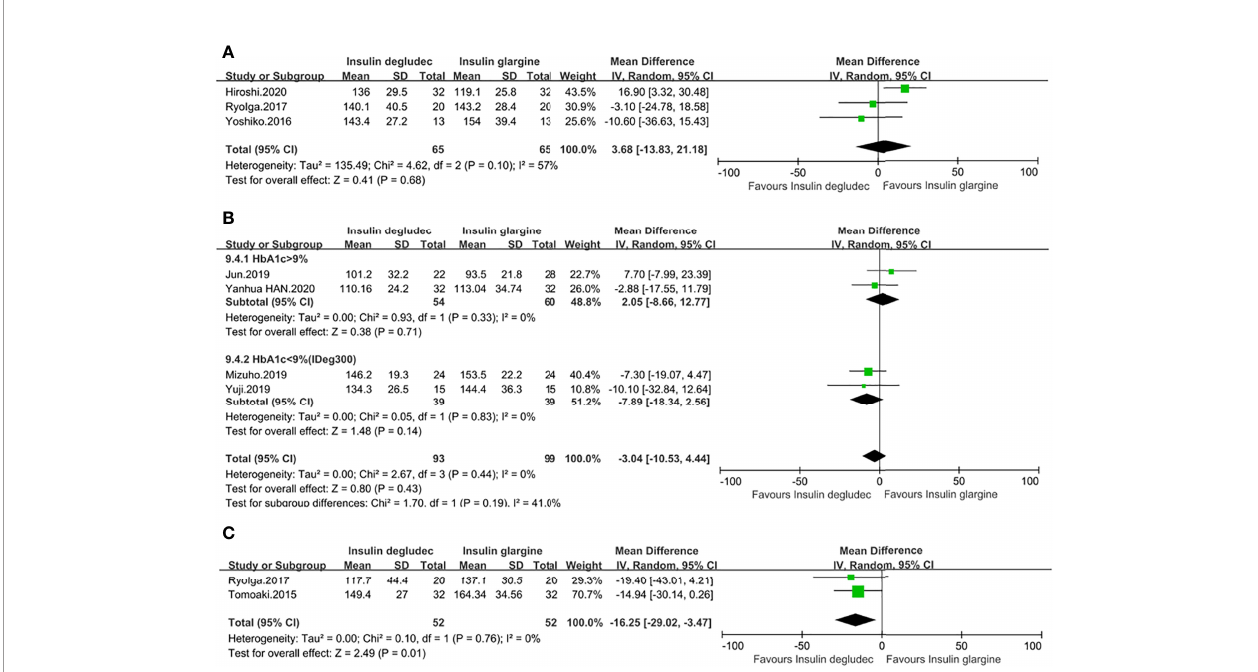
FIGURE 4 | Forest plot for the MBG. (A) MBG of 24 h in patients with type 1 diabetes; (B) MBG of 24 h in patients with type 2 diabetes; (C) The mean of FBG in patients with type 1